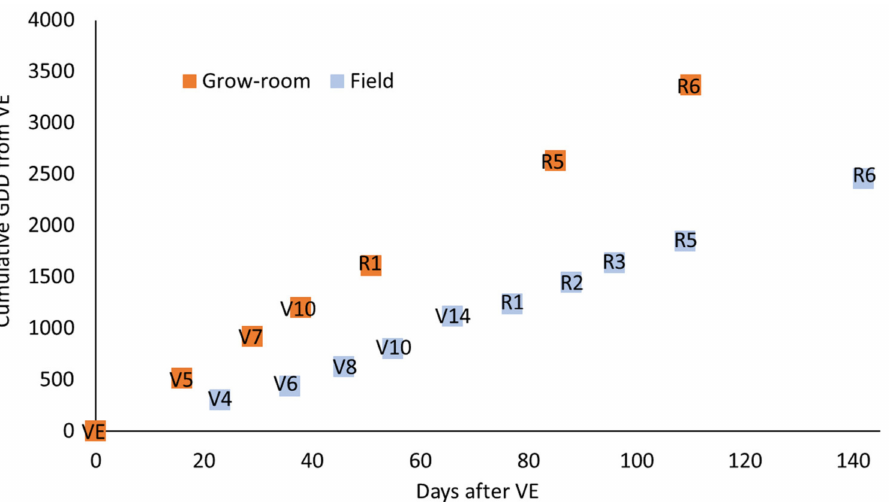
Figure 7. Maize growth stage in the indoor grow room compared to field-grown maize as a function of time (days after emergence, VE) and cumulative growing degree days (GDD). Field-grown data adapted from Abendroth et al.